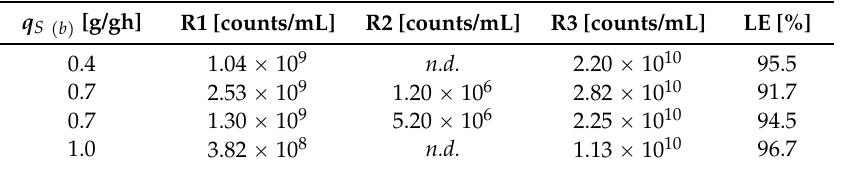
Table 2. Fermentation runs performed with different feeding profiles qS p b q during fed-batch phase. Varying the feed-profile during fed-batch phase showed no impact on lysis efficiency (LE) as determined by flow cytometry according to Equation